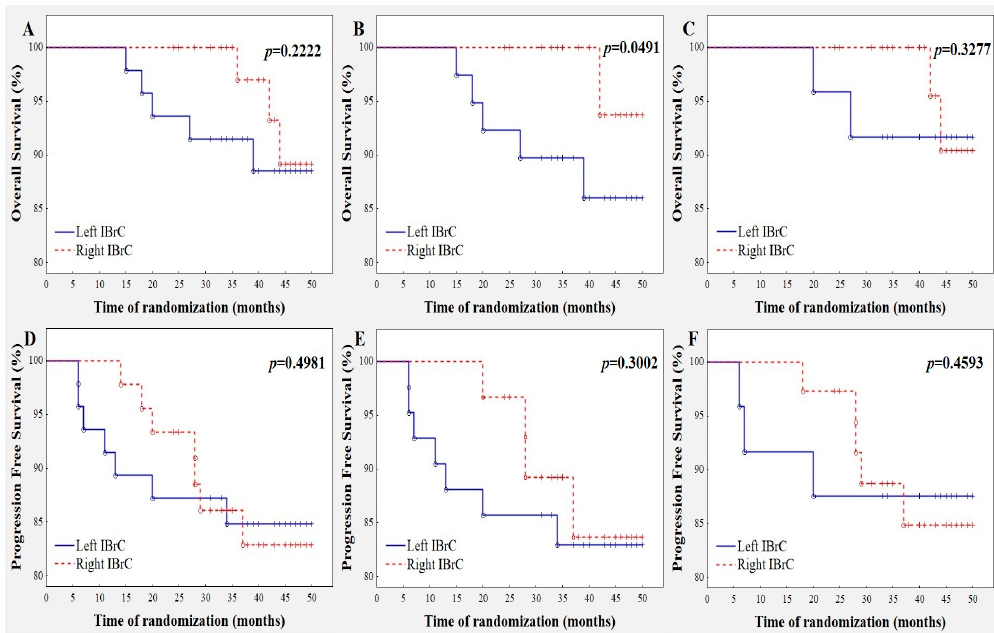
Figure 1. Crude Kaplan–Meier curves for each survival outcome for laterality category. ( A ) Overall survival for the entire study group. ( B ) Breast cancer survival for IBrC cases free of nodal involvement; p = 0.0491. ( C ) Overall survival for luminal-A breast cancer subgroup. ( D ) Progression-free survival for the entire study group. ( E ) Progression-free survival for IBrC cases free of nodal involvement. ( F ) Progression-free survival for luminal-A breast cancer subgroup. 3.7. Predictive Factors for Left/Right-Sided Invasive Breast Cancer as Assessed by Multivariate Cox’s